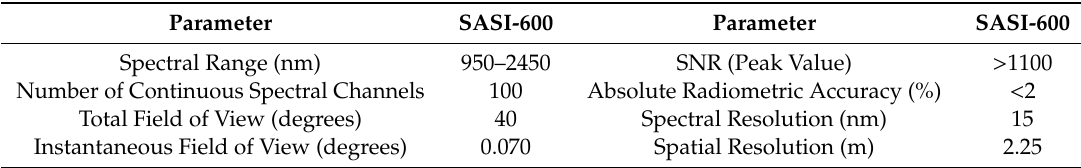
Table 3. Technical indexes of the Shortwave Infrared Airborne Spectrographic Imager (SASI). Parameter SASI-600 Parameter SASI-600 Spectral Range (nm) 950–2450 SNR (Peak Value) > 1100 Number of Continuous Spectral Channels 100 Absolute Radiometric Accuracy (%) < 2 Total Field of View (degrees) 40 Spectral Resolution (nm) 15 Instantaneous Field of View (degrees) 0.070 Spatial Resolution (m)